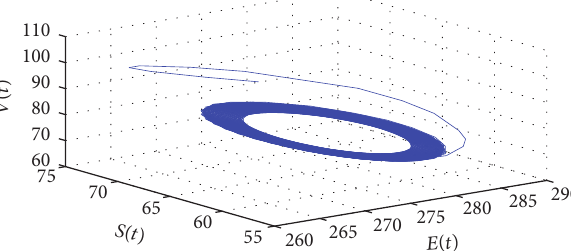
from the viral equilibrium point to a limit cycle. This makes spreading of the computer viruses be out of